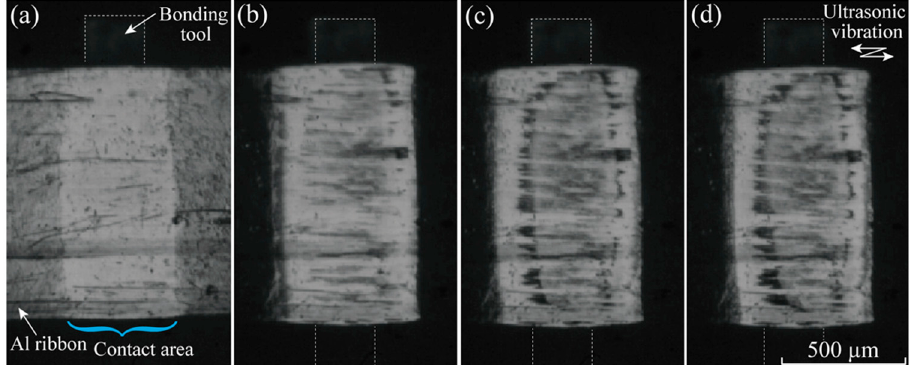
Figure 7. In-situ observation results (video captures) of the bonding interface between Al ribbon and silica substrate obtained at F rate = 10 4 fps. The bonding condition is F b = 7 N and P u = 4 W. Simultaneous measurement result of ultrasonic vibration amplitude is shown in Figure 3 (b–1): ( a ) t = 3 ms; ( b ) t = 50 ms; ( c ) t = 100 ms; ( d ) t = 400 ms.